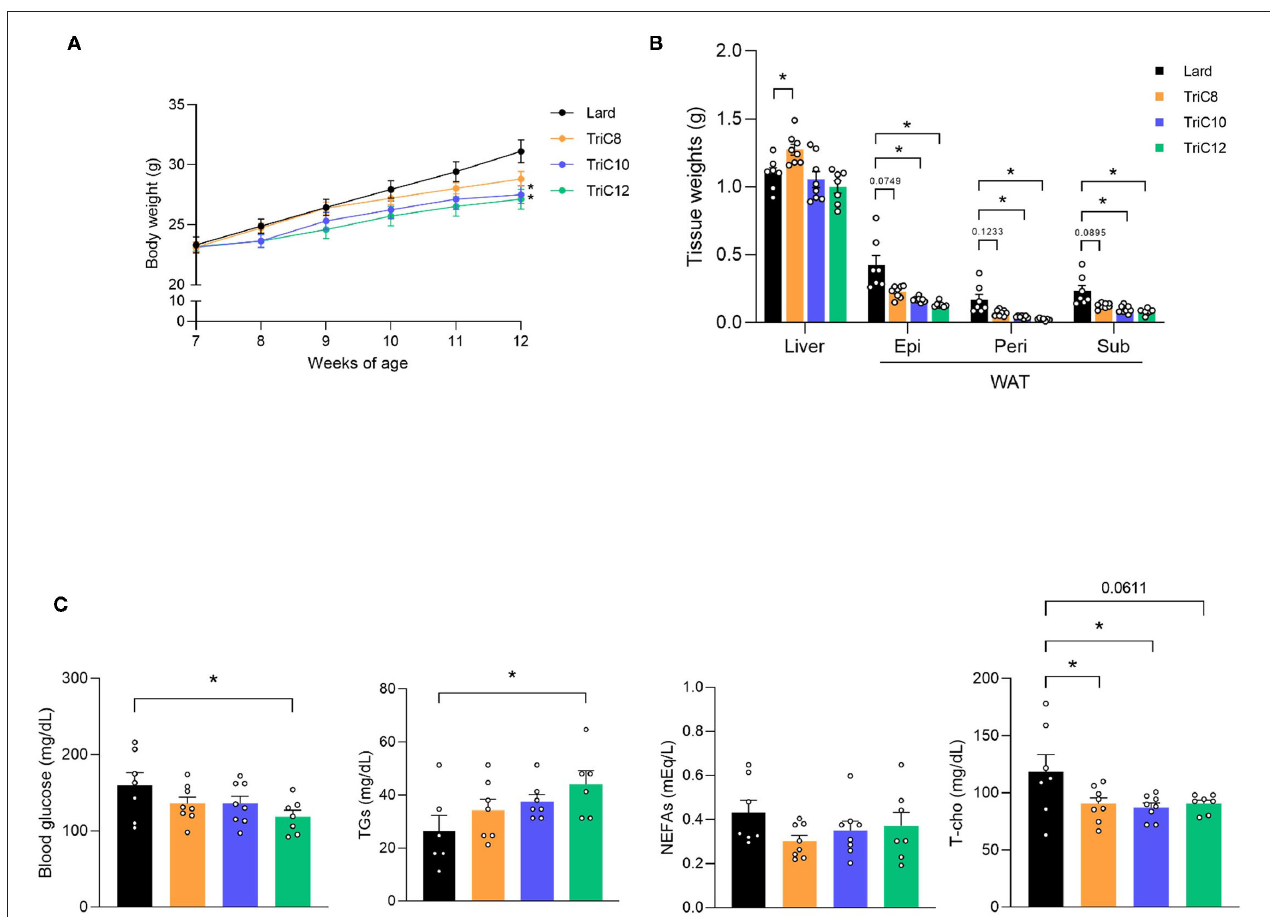
FIGURE 1 | Medium-chain triglyceride (MCT) intakes suppresses body and fat weight increase compared with lard intake. (A) Body weight gain for 5 weeks in Lard- or MCT diet-fed mice ( n = 7–8). (B) Tissue weight in Lard or MCT diet-fed mice at 12 weeks of age ( n = 7–8). (C) Blood glucose, plasma triglycerides (TGs), non-esterified fatty acids (NEFAs), and total cholesterol (T-cho) levels in Lard or MCTs diet-fed mice at 12 weeks of age were measured after fasting for 5h ( n = 6–8). Dunnett’s test; * P < 0.05, compared with Lard-diet. All data are presented as the means ± standard error of mean (SEM). Lard, Lard diet; TriC8, octanoate (C8:0) triglyceride diet; TriC10, decanoate (C10:0) triglyceride diet; TriC12, dodecanoate (C12:0) triglyceride diet. Epi, epididymal adipose tissues; peri, perirenal adipose tissues; sub, subcutaneous adipose tissues; WAT, white adipose tissue.